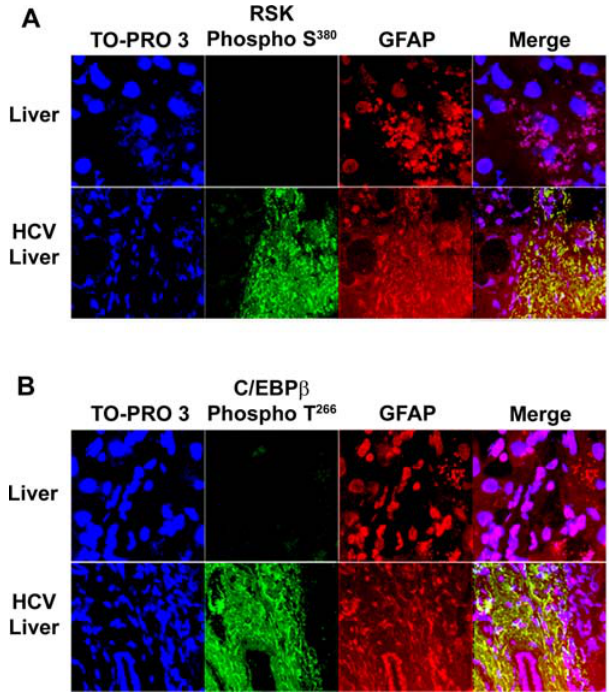
Figure 9. Increased expression of active RSK and C/EBP b -Phos- phoThr217 in activated hepatic stellate cells of human liver fibrosis. Representative confocal microscopy of 4 patients with severe liver fibrosis and 3 control subjects. A. Activated HSC, identified by confocal microscopy for their morphology and fluorescence for glial fibrillary acidic protein (GFAP; red), displayed activated RSK-PhosphoSer380 in livers of patients with severe liver fibrosis (lower panel) but not in the livers of control subjects (upper panel). Colocalization of RSK- PhosphoSer380 and GFAP is shown in yellow (merge). Nuclei are identified with TO-PRO-3 (blue). Only background staining was observed when omitting the first antibody. B. C/EBP b -PhosphoThr217 (green) was present in activated HSC only in livers of patients with liver fibrosis (lower panel). Colocalization of C/EBP b -PhosphoThr217 and GFAP (red) is shown in yellow (merge). Nuclei are identified with TO- PRO-3 (blue).